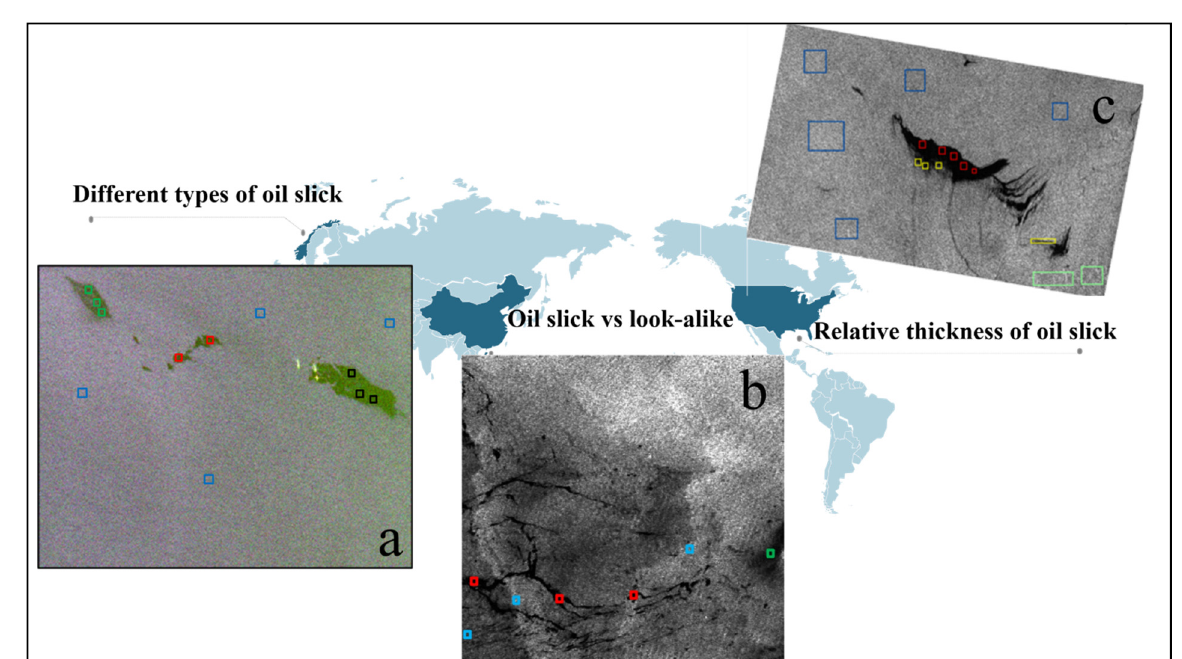
Figure 1. Locations of marine oil spill images obtained by RADARSAT-2 and utilized in this study: ( a ) Case 1; ( b ) Case 2; ( c ) Case 3.